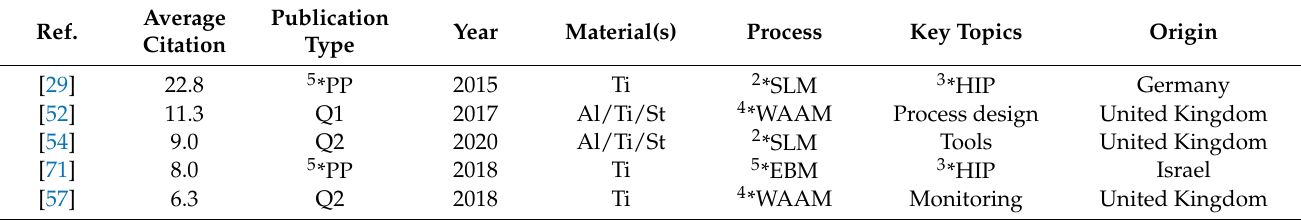
Figure 5. High-cycle fatigue test results obtained on specimens before and after HIP treatment, reproduced from [56], with permission from Elsevier, 2021. Table 6. Top 5 articles on additive